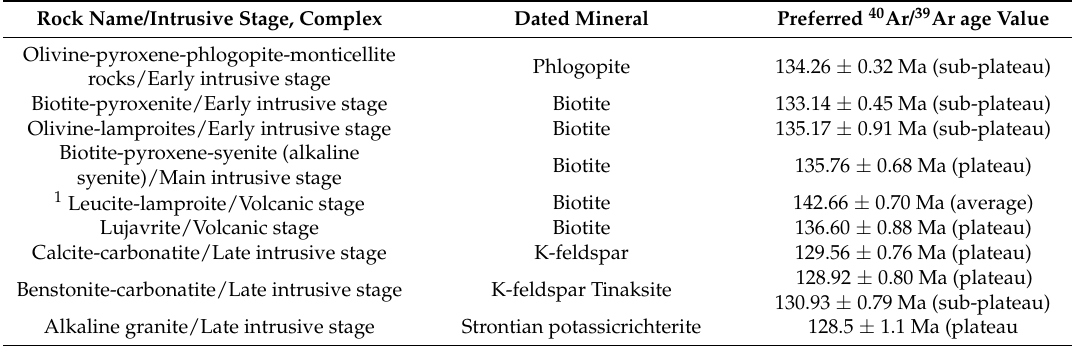
Table A1. Summary of Geochronological